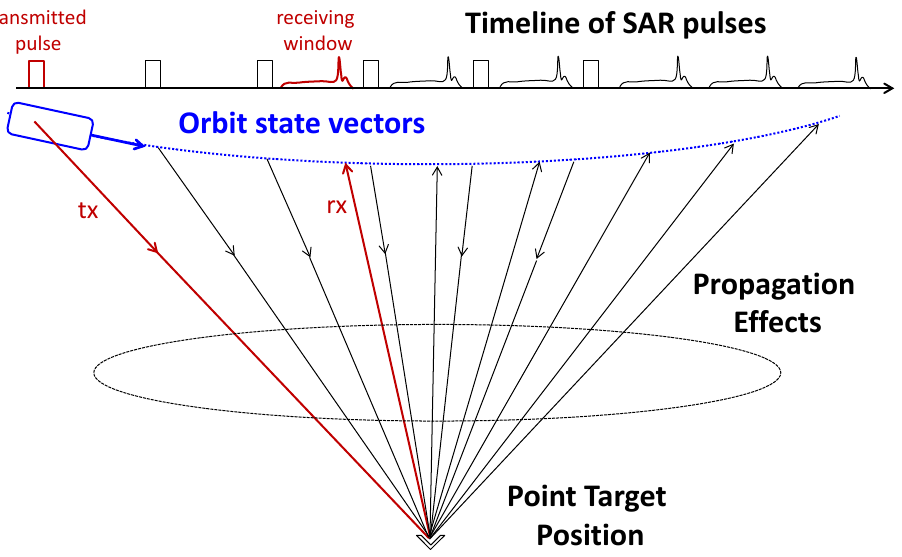
Figure 1. SAR observation scheme containing main parameters that have to be considered for geometric retrieval: the orbit state vectors and the target position define the geometry between spacecraft and target; the pulse timeline stored in the raw data headers contains information about transmitted ( tx ) and received ( rx ) SAR pulses. Additional delays are caused by propagation effects through the troposphere and